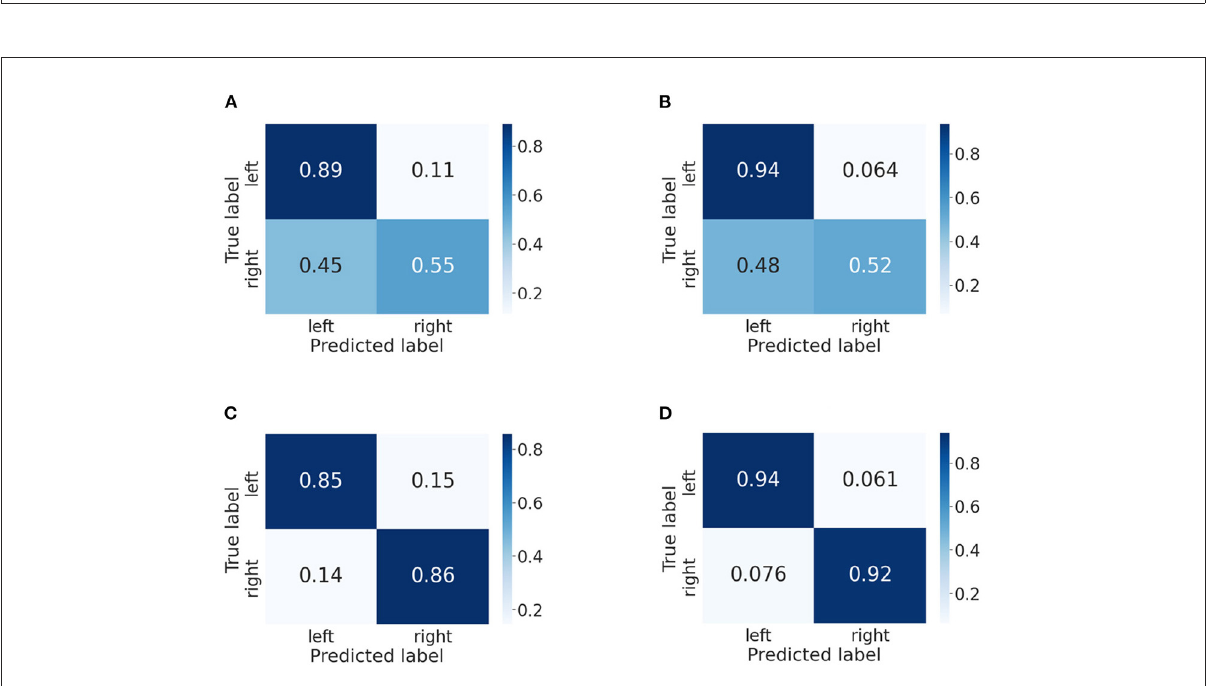
FIGURE6 Confusion matrices of BCI competition IV-2b datasets. (A) B01 without our method. (B) B01 with our method. (C) B02 without our method. (D) B02 with our